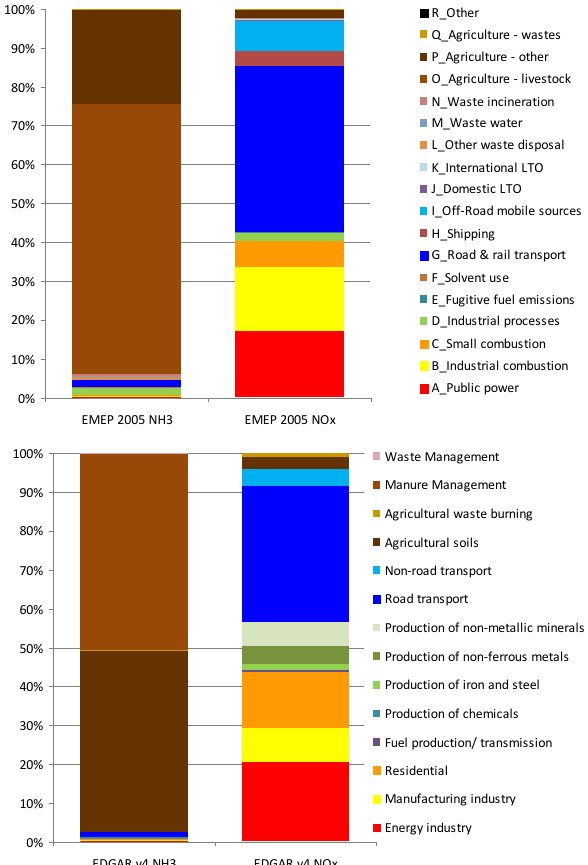
Fig. 7. Sectoral comparison of emissions for the year 2005 between EMEP (top; EMEP, 2009) and EDGAR v4 (bottom; EDGAR, 2009) for the EU27 countries (excluding Malta and Cyprus). It should be noted, that the EMEP sectoral split is based on only 10 countries reporting according to the latest sectoral structure (NFR 08, Level 1), which is best comparable with the EDGAR v4 sector structure. In addition to that, a likely reason for these large differences are assumptions regarding underlying emission factors for some of the largest contributing sources, e.g. due to the